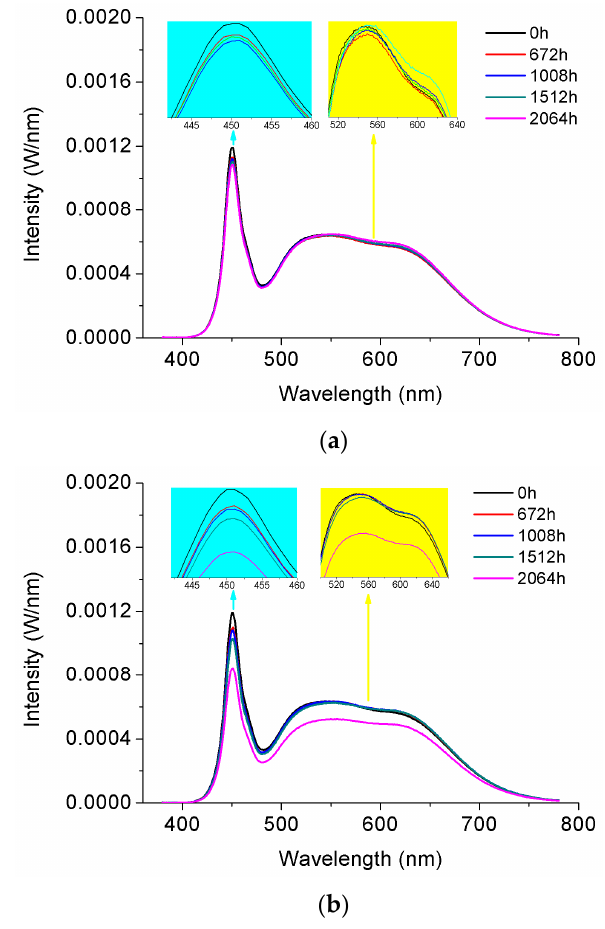
Figure 10. Attenuation of spectrum power distributions of the 5000 °K samples during SSADT. ( a ) Driving by a 120 mA current; ( b ) Driving by a 350 mA current.